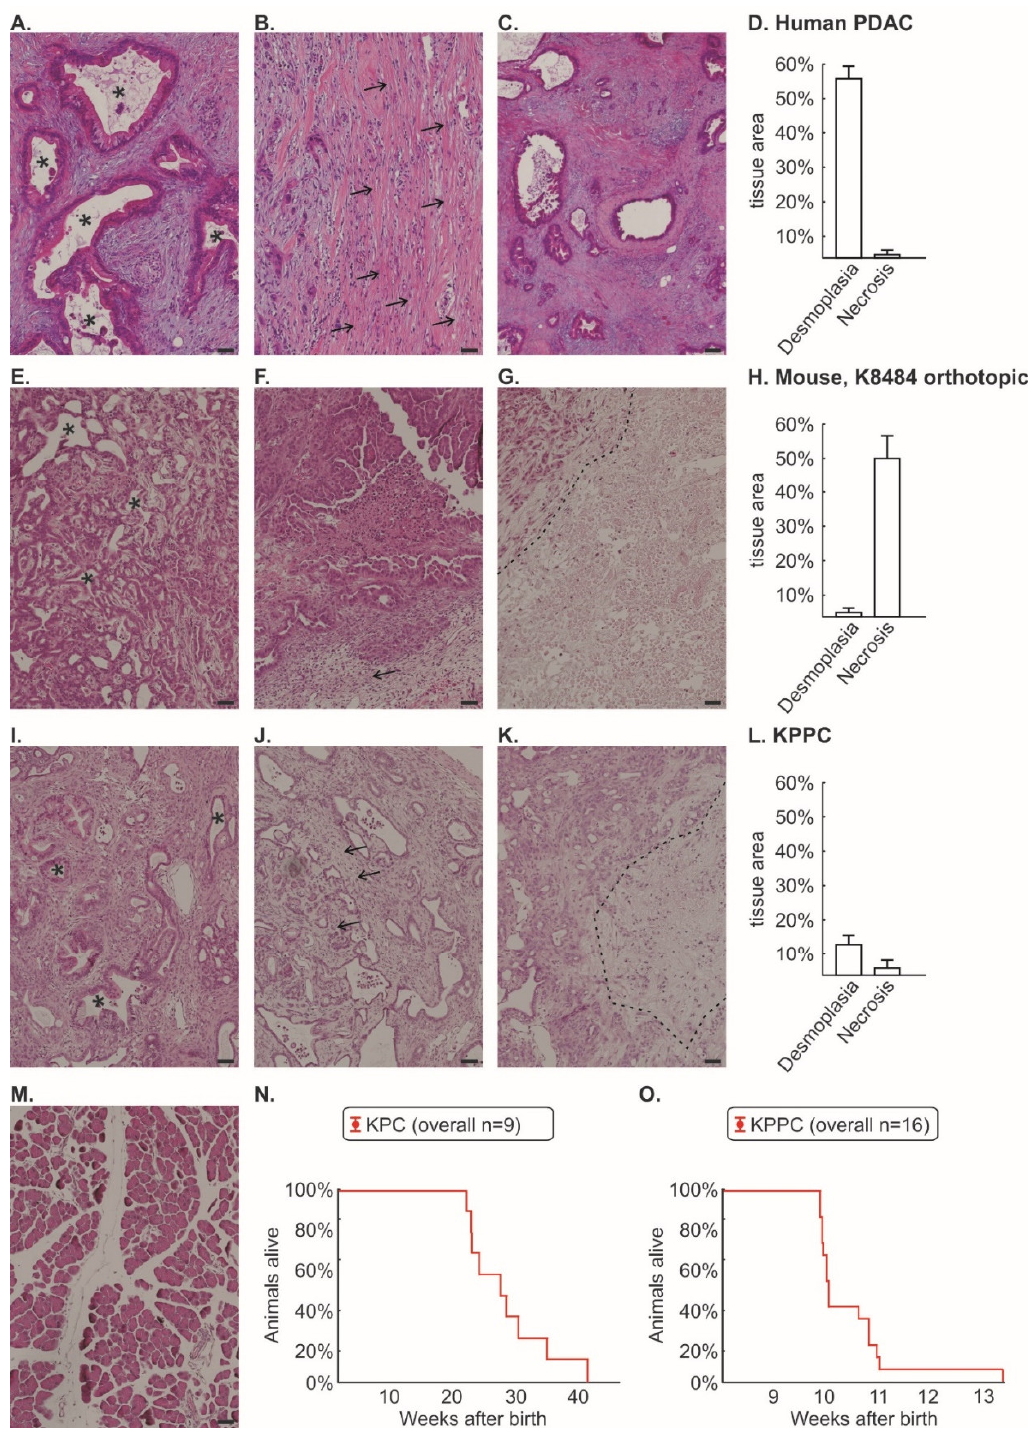
Figure 1. Histological comparison between human pancreatic cancer, murine orthotopic K8484 injection, KPC mice and KPPC mice. Post mortem histological staining of pancreatic tissue was performed using Hematoxylin and Eosin (H&E) in human pancreatic cancer (n = 24, ( A – C )); murine cancer model with orthotopically injected K8484 cells (n = 13; ( E – G )); KPPC mice (n = 11; ( I – K )) and control mice ( M ). The areas of desmoplasia and necrosis were quantified for human pancreatic cancer ( D ), murine cancer model with orthotopically injected K8484 cells ( H ) and KPPC mice ( L ).